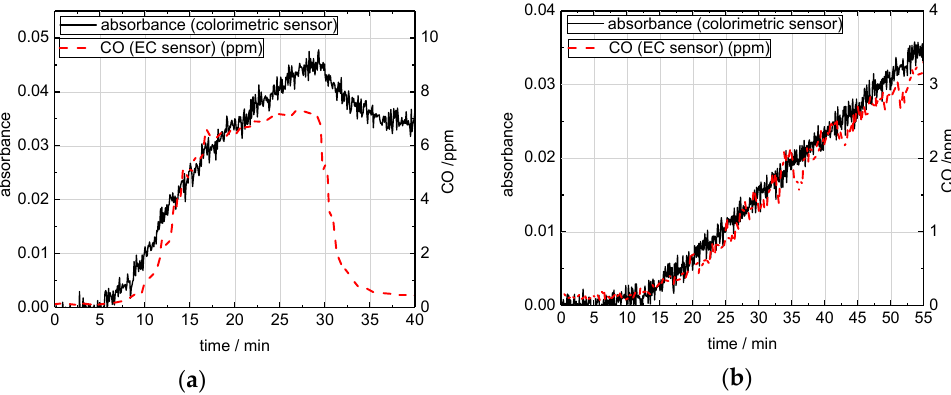
Figure 3. Comparison of the response of a colorimetric sample in ATR mode at a wavelength of 470 nm and the measured CO concentration ( a ) to gases from a smoldering wood fire type TF2a as described in EN54; ( b ) to gases from a slowly evolving smoldering wood/plastics